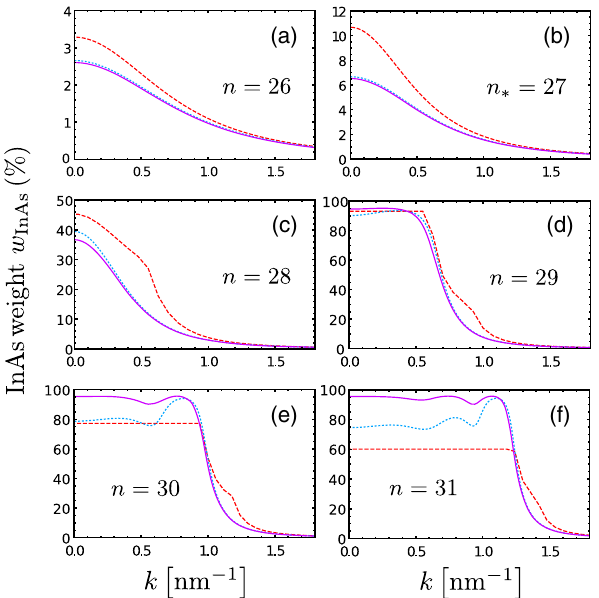
FIG. 5. (a) – (f) InAs weights for L 1 ¼ 5 nm and Φ ¼ 0 . 1 eV. Solid purple line: Weights obtained numerically using the self- consistent Schrödinger-Poisson method for L 2 ¼ 100 nm. Dotted blue line: Weights obtained numerically using the Schrödinger equation within the square-well model for L 0 2 ¼ 16 nm. Dashed red line: Weights obtained within the square-well model using the